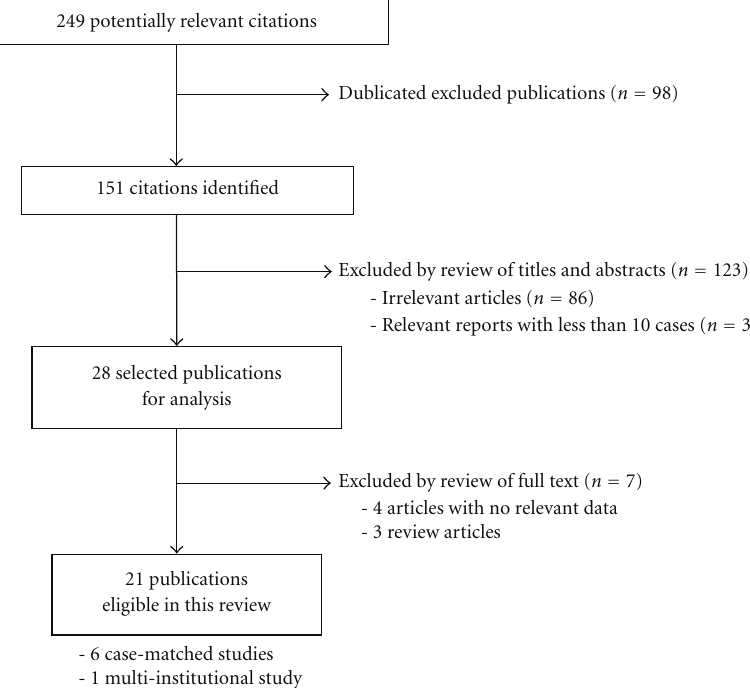
Figure 2: Flow chart of the selection process for studies included in the systematic